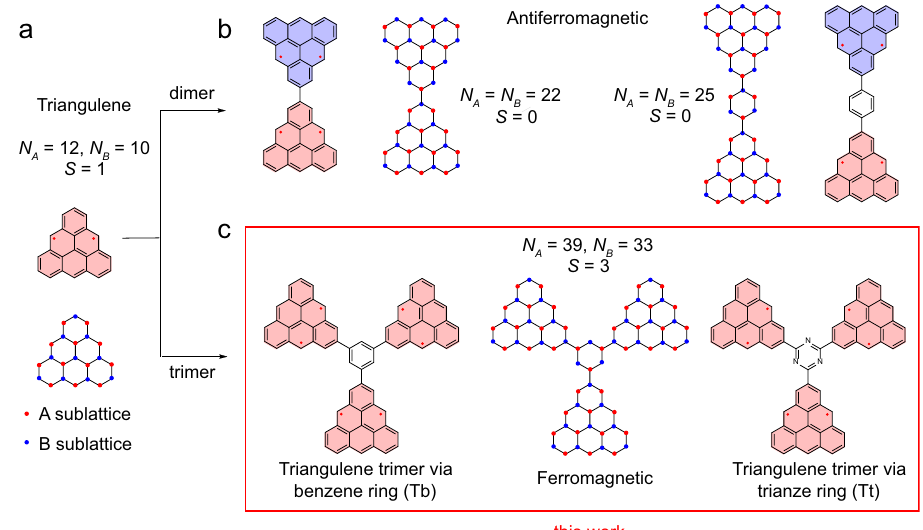
Fig. 1 Magnetic coupling in triangulene dimers and trimers. a Chemical structure of triangulene with unpaired electrons. Two interpenetrating triangular sublattices highlighted as blue and red fi lled circles giving S = 1 magnetic ground state. The symbols A and B are represented as carbon atoms of two interpenetrating sublattices in the nanographene structure. b Schematic drawings for two kinds of triangulene dimers with antiferromagetic ordering. c Schematic drawings for triangulene trimers connected with benzene or triazine ring. The net sublattice imbalance of six in these structures give rise to S = 3 high-spin ground state. The fi lling colors in triangulenes denote their ferromagnetic or antiferromagnetic